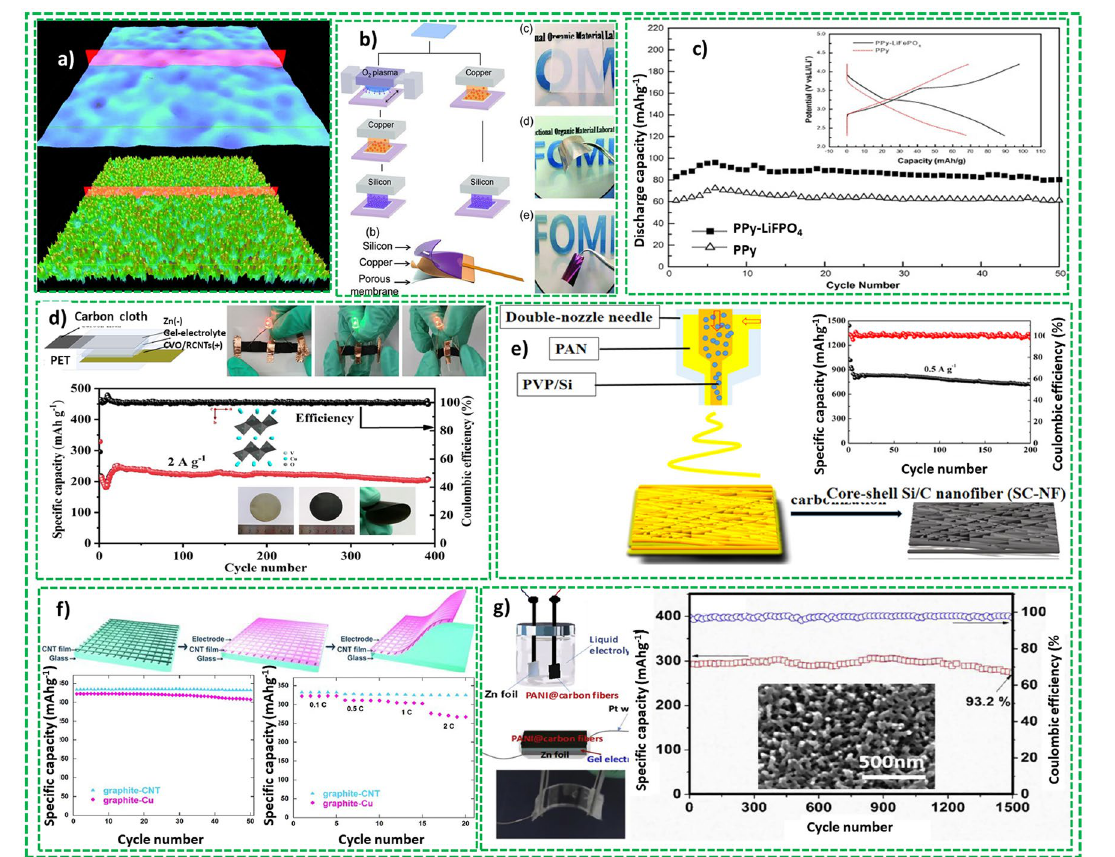
Fig. 16 a Surface morphology of a rough cupper substrate. Reproduced with permission from Ref. [175]. b Demonstration of multilayer silicon electrode fabrication. Reproduced with permission from Ref. [176]. c Cyclic stability comparison of PPy and PPy-LiFePO 4 deposited material, inset illustrates the discharge/charge curves of the 10th cycle Reproduced with permission from the reference Ref. [177]. d Graphic diagram of flexible gel Zn//CVO-18/RCNTs battery, demonstration of two flexible gel Zn//CVO-18/RCNTs batteries in series to light up a 1.5 V led bulb at different bending states and cyclic performance of the battery. Reproduced with permission from Ref. [178]. e Diagram of synthesis of the SC-NF composites using electrospinning technique and cyclic performance of the battery. Reproduced with permission from Ref. [179]. f Graphic illustration of the method of making flexible electrodes with SACNT films working as lightweight and thin current collectors, Cycling performance of battery at (0.1C) and rate performances of the graphite-CNT and graphite-Cu electrodes. Reproduced with permission from Ref. [180]. g Schematic illustration of 3-electrode setup for electrochemical performance of PANi grown on carbon fibers, digital image of ZIB and cyclic performance of ZIB at 4 A g −1 (the inset SEM image after 1500 cycles) Reproduced with permission from Ref.